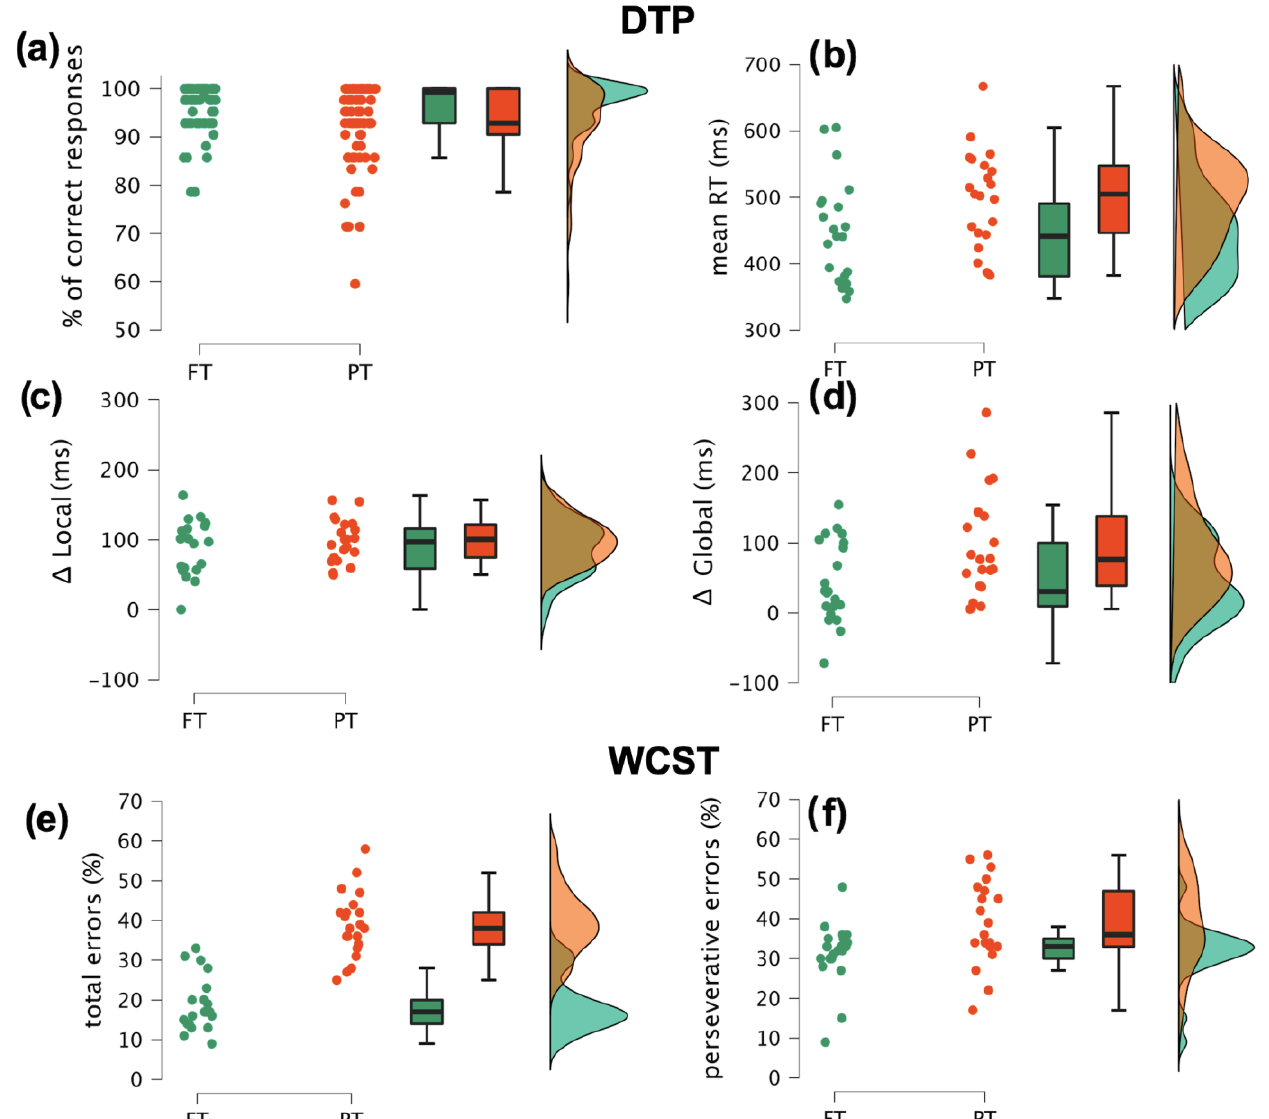
Figure 2. Behavioral data. The figure shows the single-subject values (dots), the box plots and the rainclouds clustered by group. The four upper panels refer to the DTP task and represent the global mean response accuracy ( a ), the global mean response speed ( b ), the mean response speed adjustment as a function of local ( ∆ local = short SOA RTs minus long SOA RTs) ( c ) and global ( ∆ global = slow block RTs minus fast block RTs) ( d ) stimulus predictability. The two bottom panels display the percentage of total ( e ) and perseverative ( f ) errors at the WCST